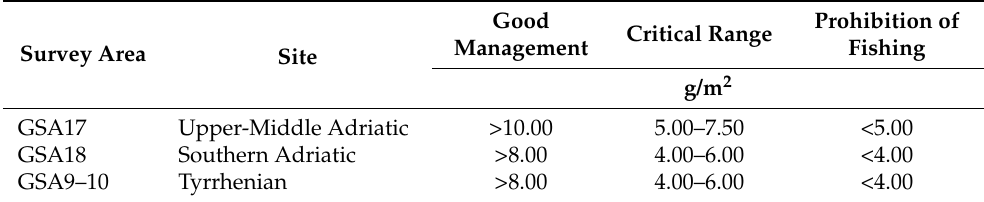
Table 1. Reference values of clam density (g/m 2 ) in the various FAO Geographical Sub Areas (GSAs) (Reg. (EC) n. 1967/2006)